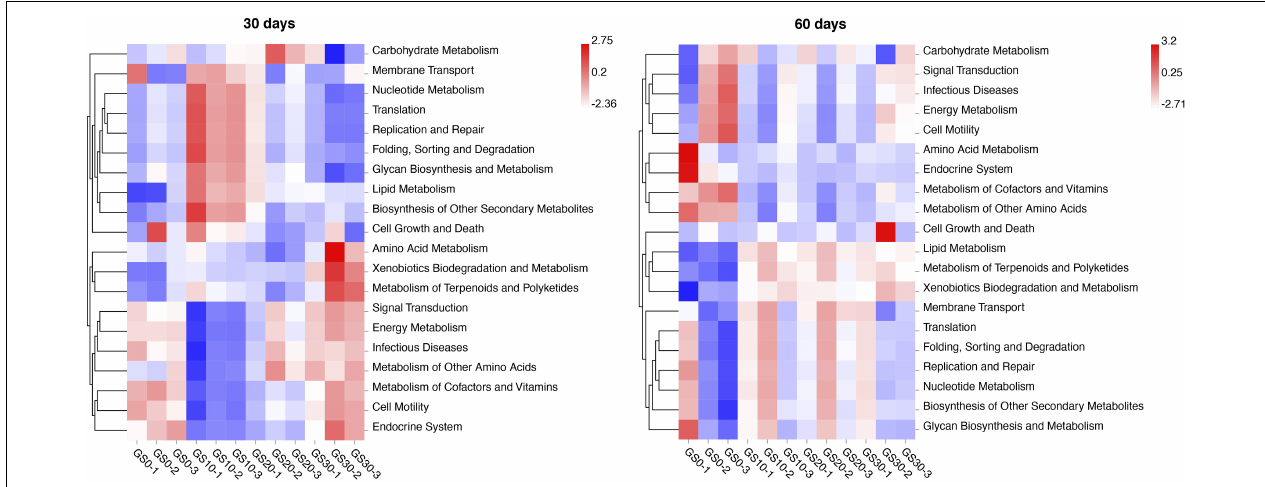
FIGURE 4 | Bacterial functional predictions (top 20 in abundance) for Pennisetum hydridum ensiled with garlic skin at days 30 and 60 of ensiling obtained with Tax4Fun (GS0, 100 wt% Pennisetum hydridum ; GS10, 90 wt% Pennisetum hydridum + 10 wt% garlic skin; GS20, 80 wt% Pennisetum hydridum + 20 wt% garlic skin; GS30, 70 wt% Pennisetum hydridum + 30 wt% garlic